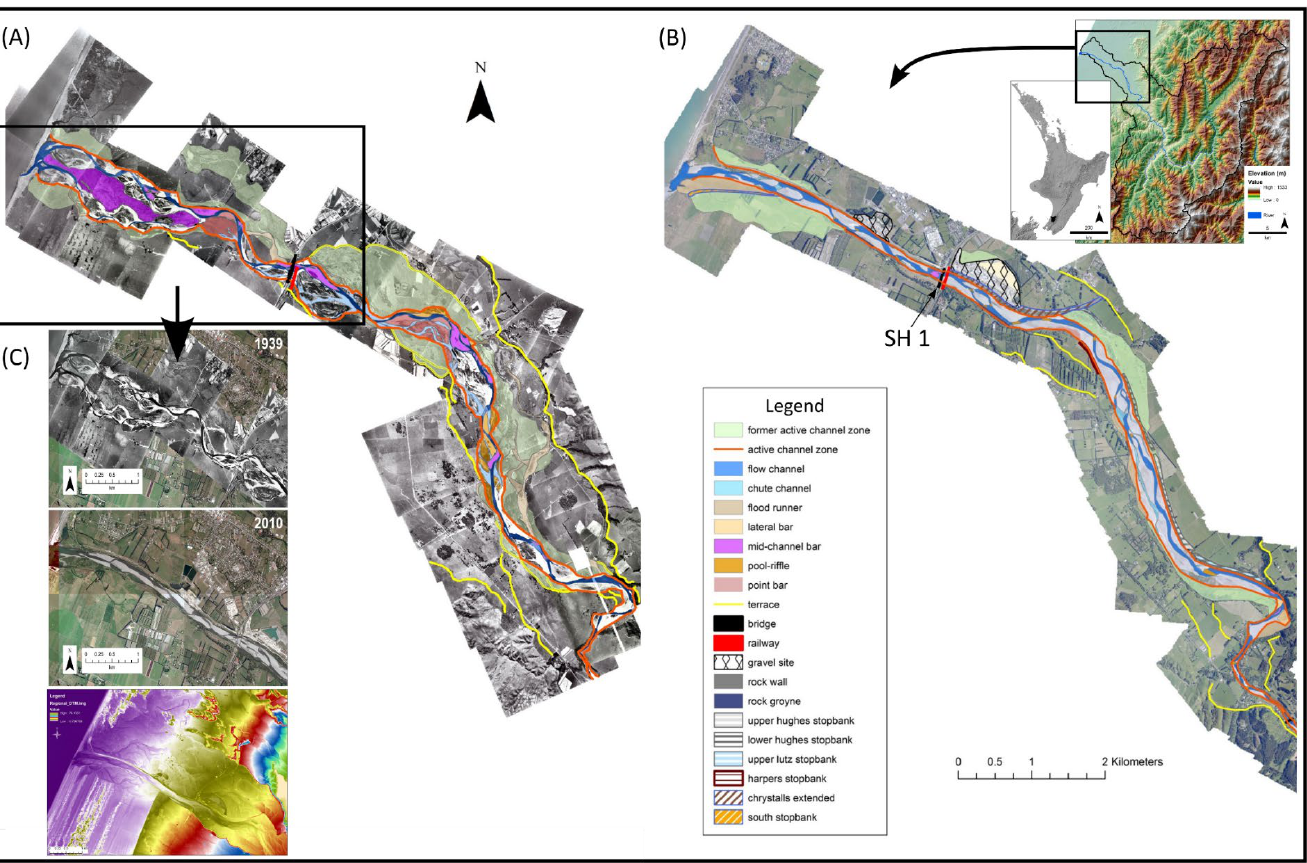
Figure 7. ( A ) River geomorphology in 1939 prior to engineering; ( B ) modified geomorphology and engineering structures in 2016; ( C ) earliest available aerial imagery of lower Ōtaki River (1939), compared with the modified river in 2010 and a LiDAR-derived digital elevation model (DEM). The DEM shows the extent of the Ōtaki floodplain inset between higher alluvial surfaces (east), coastal dunes (west and north) and former beach ridges (west and south). The diversity of the pre-engineered river in 1939 is clear. The rich mosaic of geomorphic units (multiple wet and dry channels, anabranches, gravel bars, vegetated bars) presents a stark contrast to the uniformity and dominance of human structures in the engineered river. The permitted floodplain has been narrowed by up to 90% and the active channel by around 50% [62]. Crossing of State Highway 1 (SH1) referred to in text is labelled in ( B ), central legend applies to ( A , B